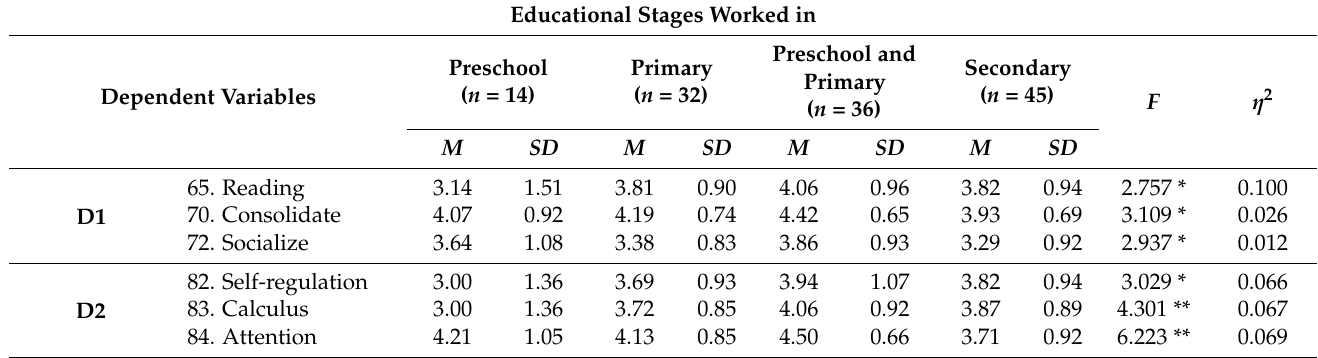
Table 10. Significant differences in the benefits and uses of apps as a function of the educational stage taught by the teachers from Florence.